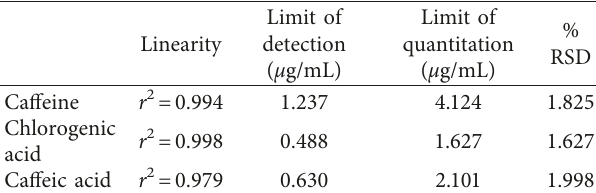
Table 1: Methods of validation requirement: linearity, limit of detection (LOD), limit of quantitation (LOQ), and %